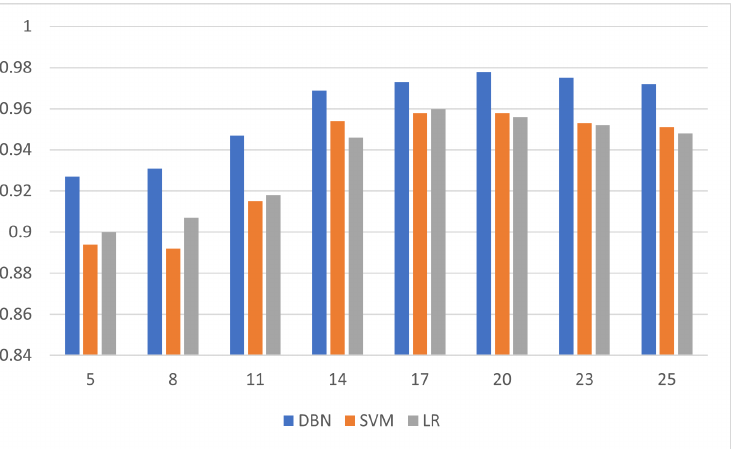
Figure 4. Comparison of the proposed ADBN-IDS with SVM and LR in terms of F